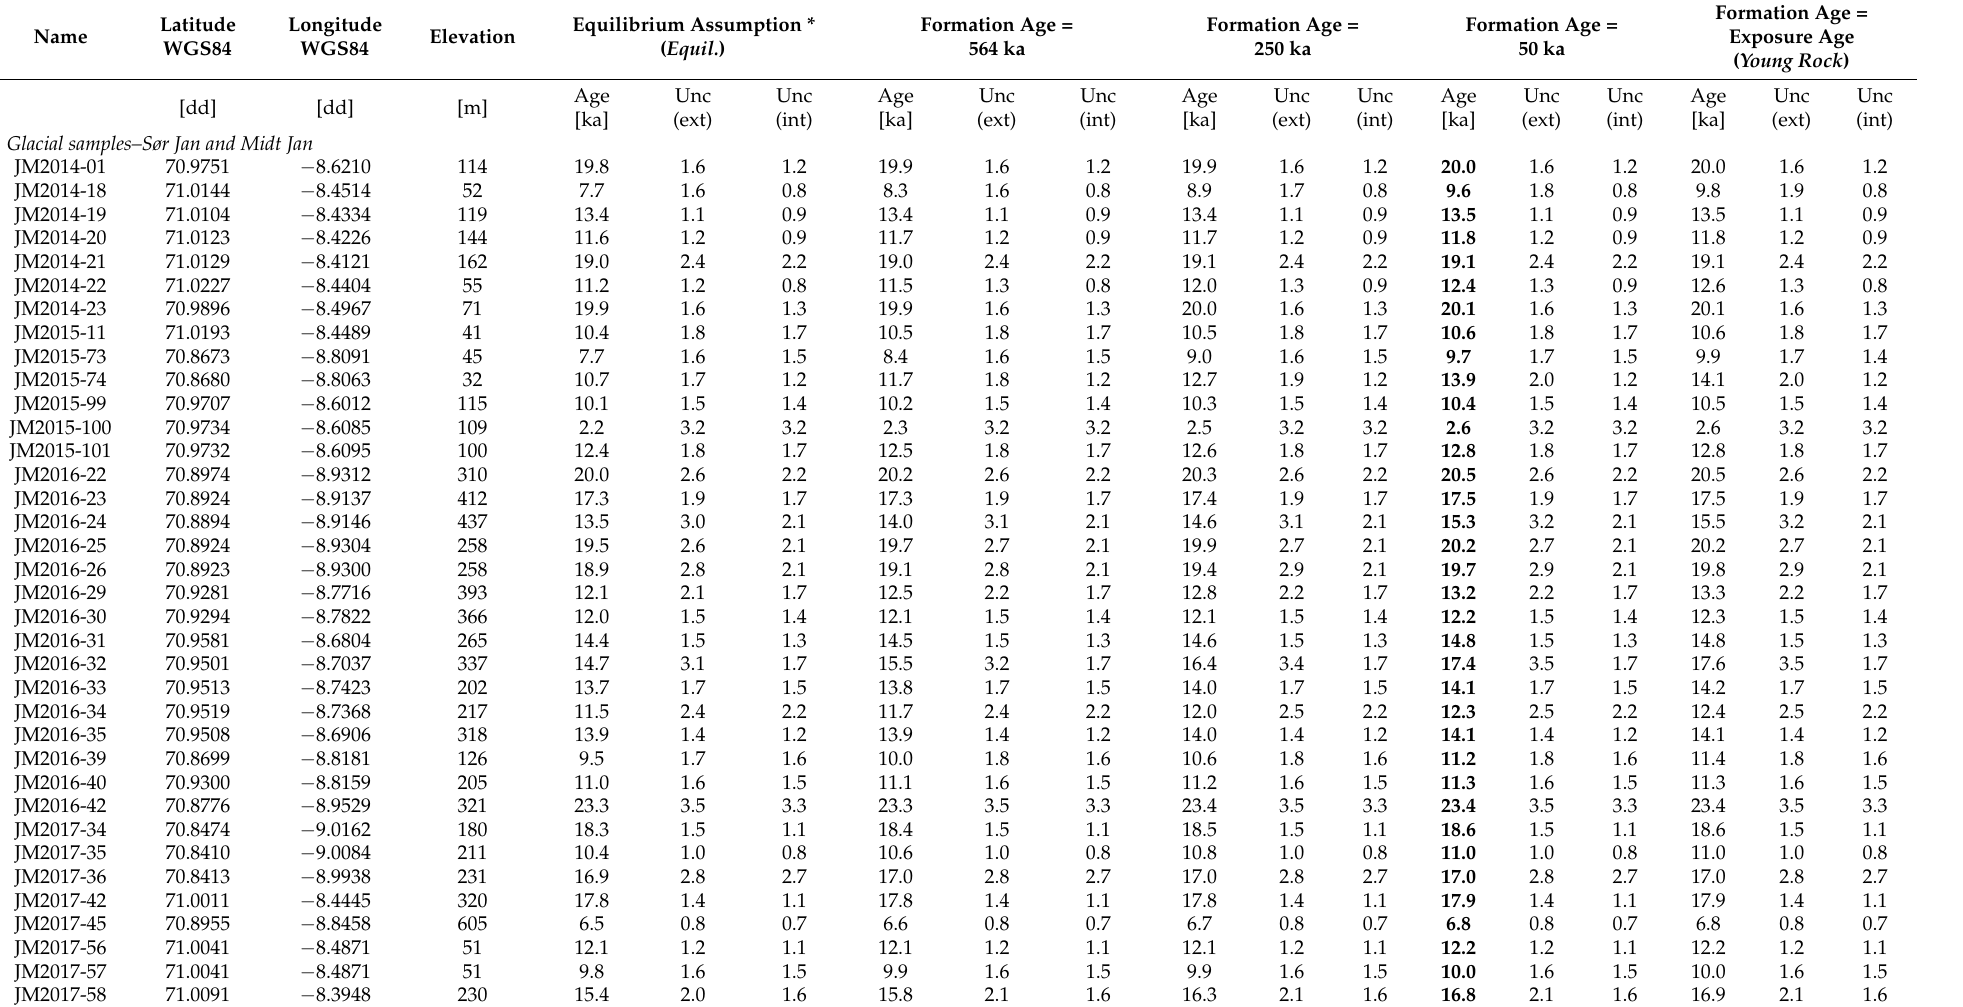
Table 2. Exposure ages calculated using five different scenarios for the background production. Our best estimate ages are indicated in bold. Calculated using LM scaling and assuming a density of 2.1 ± 0.5 g/cm 3 and an erosion rate of 1 ± 0.5 mm/ky. See Supplementary Table S2 for the full set of sample information used in the